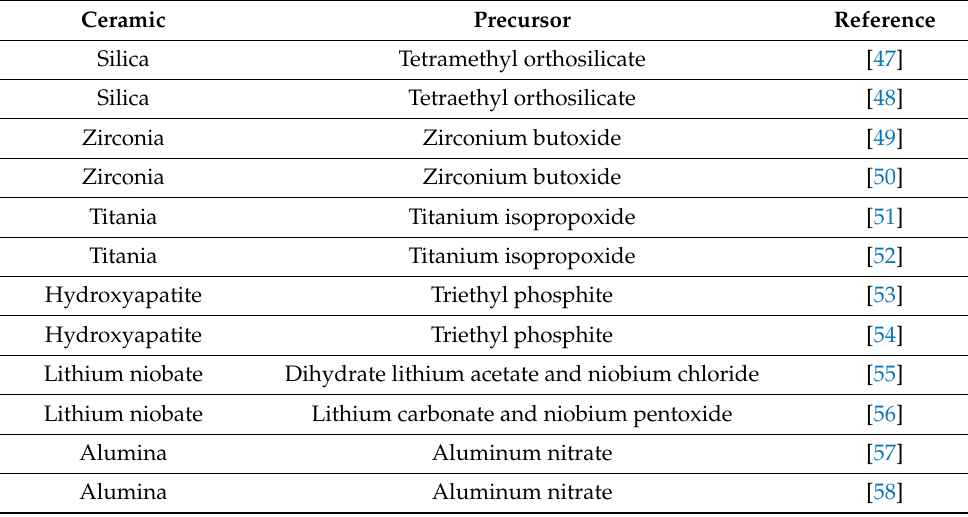
Table 1. Examples of ceramics obtained by the sol–gel method. Ceramic